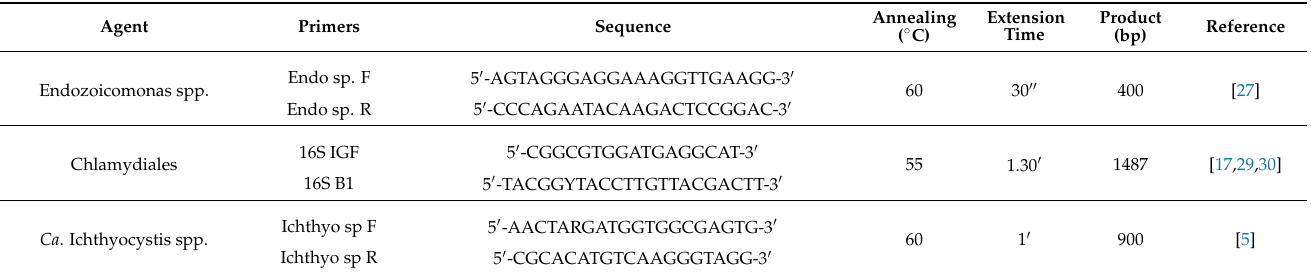
Table 1. Primers, primer sequences, and PCR conditions used in this study to amplify partial 16S rRNA of known epitheliocystis